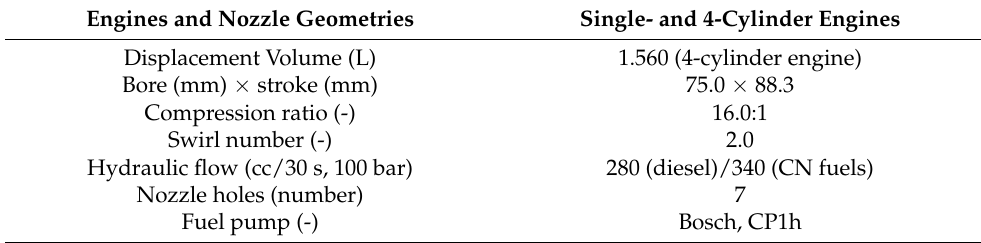
Table 2. Specification of engines and